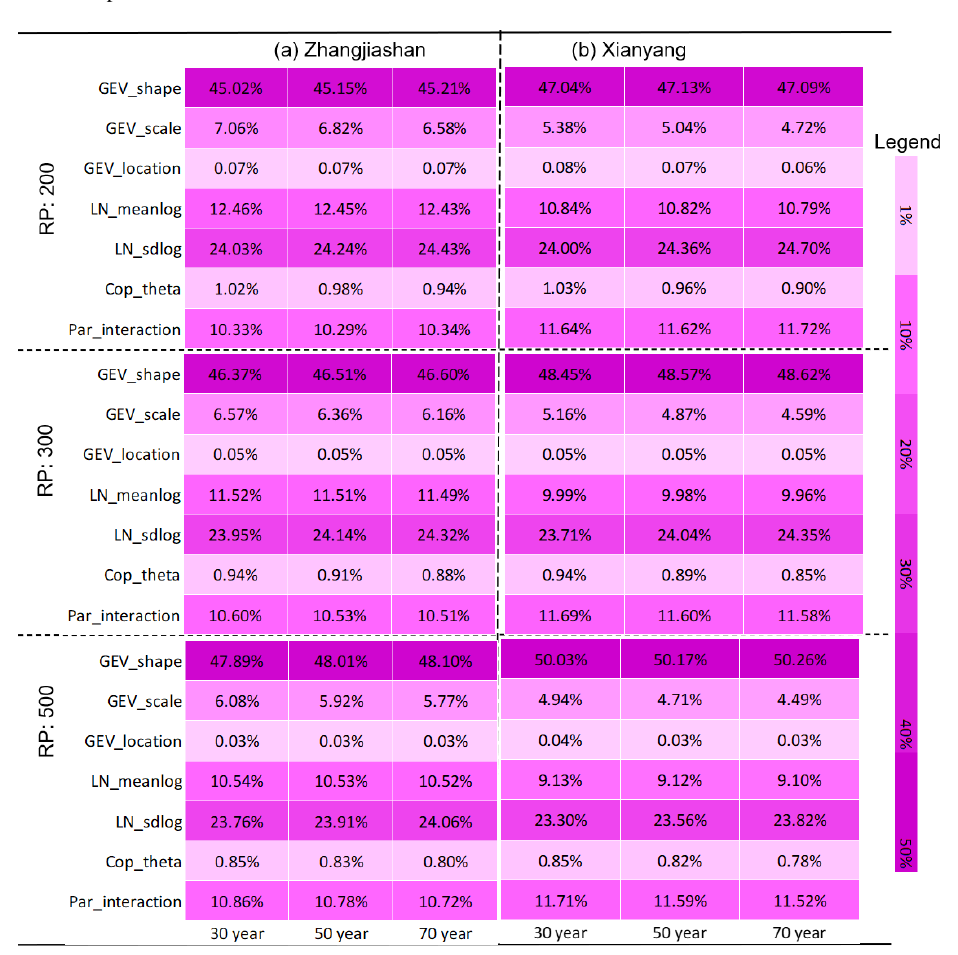
Table 8. Contributions of parameter uncertainties to predictive failure probabilities in OR under different design standards (i.e. return periods – RPs) and different service